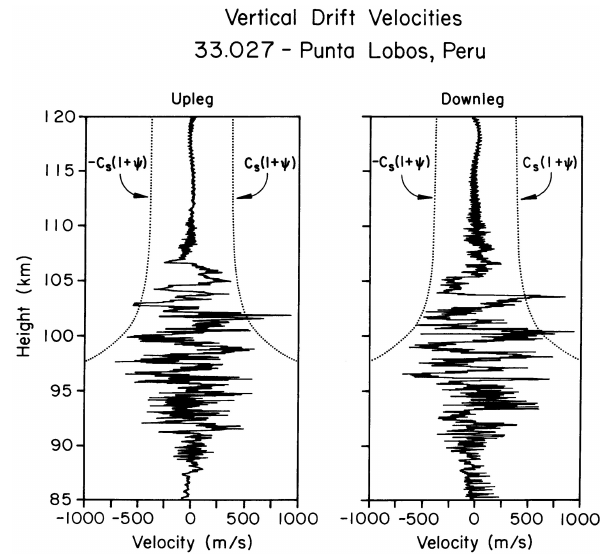
Fig. 7. Comparing the rocket data of the previous figure to the ion- acoustic threshold (from Pfaff et al.,